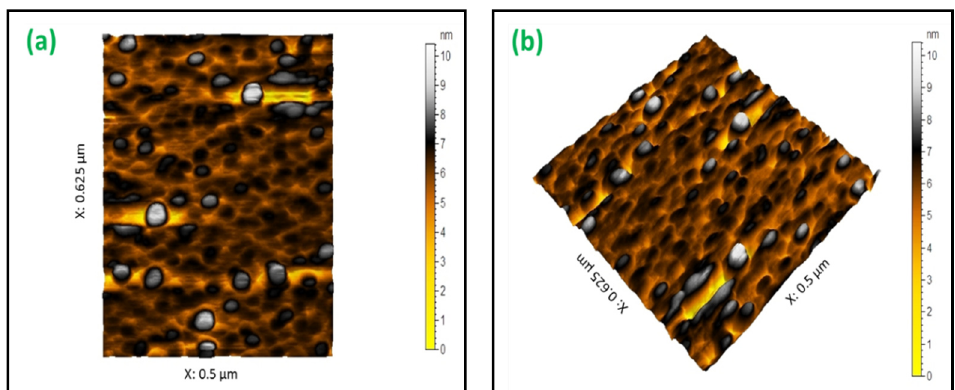
Figure 6. ( a , b ) AFM topographical images of the synthesized SiO 2 NPs from RHA.